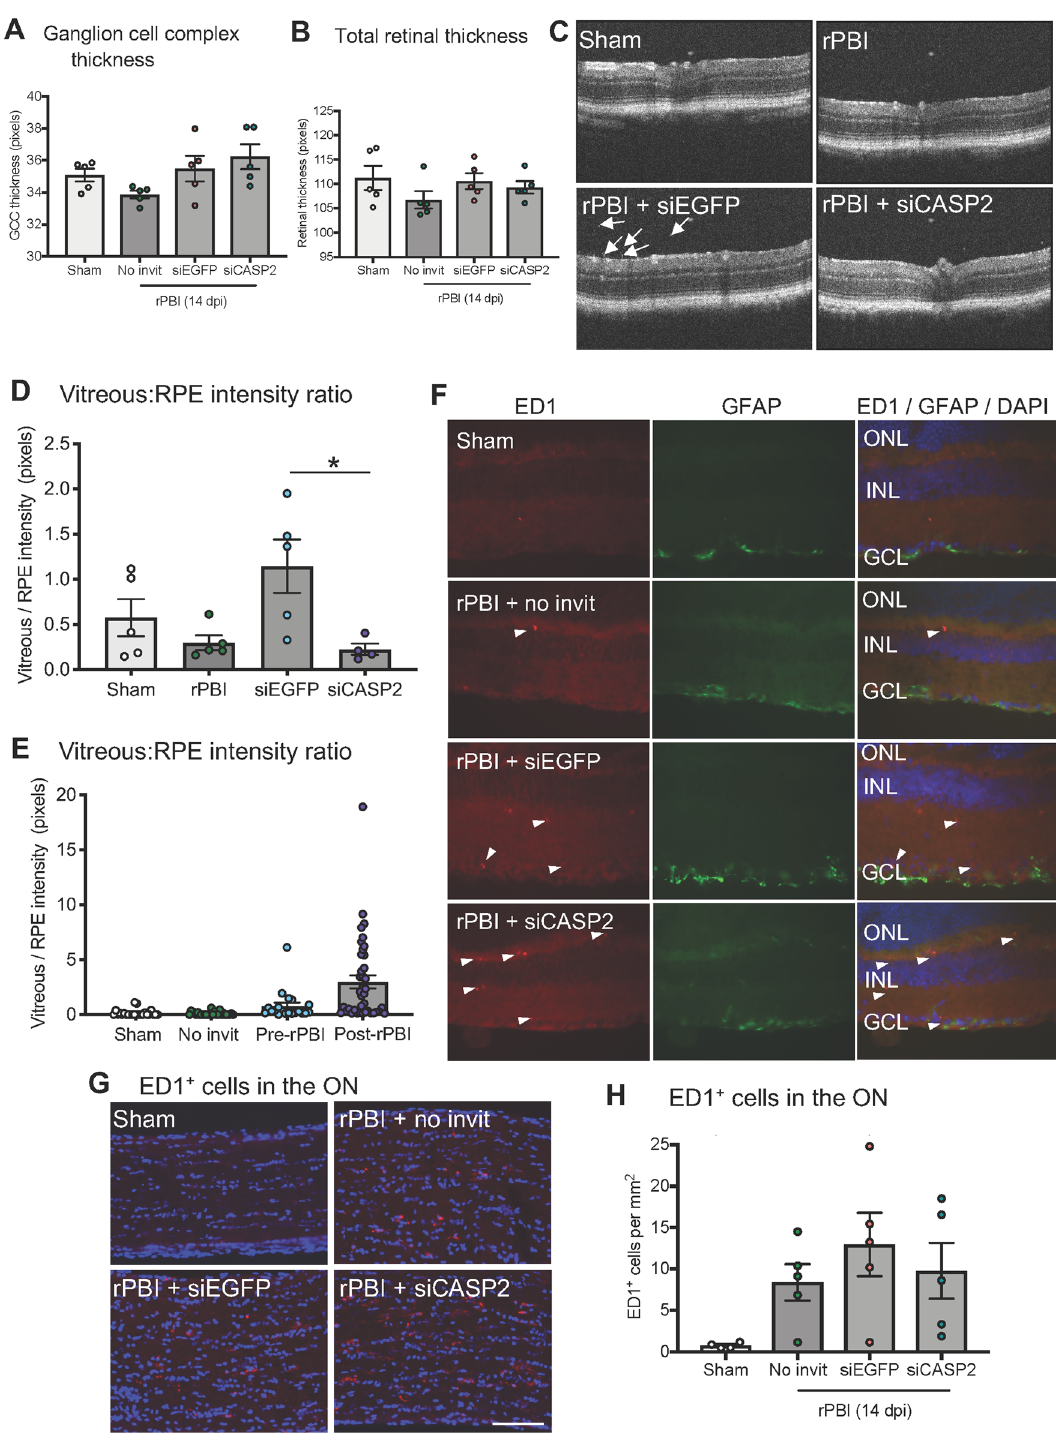
Figure 5. b-ITON and “pre-blast” injections had no effect on retinal thickness, but there were differential effects on vitreal inflammation. ( A ) There were no significant differences in GCC between any groups (P = 0.1016, ANOVA). ( B ) There were also no differences in total retinal thickness across any groups (P = 0.7667, ANOVA). ( C ) Representative OCT retinal scans used to quantify vitreal haze (arrows show examples of vitreous haze). ( D ) Vitreous intensity normalized to RPE intensity increased after b-ITON and siEGFP compared to b-ITON alone (P = 0.002), but did not increase with siCASP2 injections and remained similar levels to b-ITON alone (P > 0.05). There was a significant decrease in vitreous intensity between siEGFP and siCASP2 injected eyes (P = 0.033, post-hoc Tukey). ( E ) Vitreous intensity normalised to RPE intensity was also compared between grouped siCASP2 and siEGFP injections administered “pre-blast” and “post-blast”. There was greater vitreal intensity after b-ITON with “post-blast” intravitreal injections at 28 dpi compared to b-ITON with “pre-blast” intravitreal injections at 14 dpi (P = 0.001, GEE). ( F ) Representative retinal IHC images stained with DAPI (blue), ED1 (red) and GFAP (green) showing retinal ED1 + cell infiltration after b-ITON and greater after b-ITON with siCASP2 and siEGFP intravitreal injections. ( G ) Representative ON IHC images for DAPI (blue) and ED1 (red). ( H ) There was weak evidence for an increase in ED1 + cells in the ON in b-ITON groups (P = 0.075, ANOVA). Scale bars in ( F,G ) = 100 μm. Error bars represent mean ±